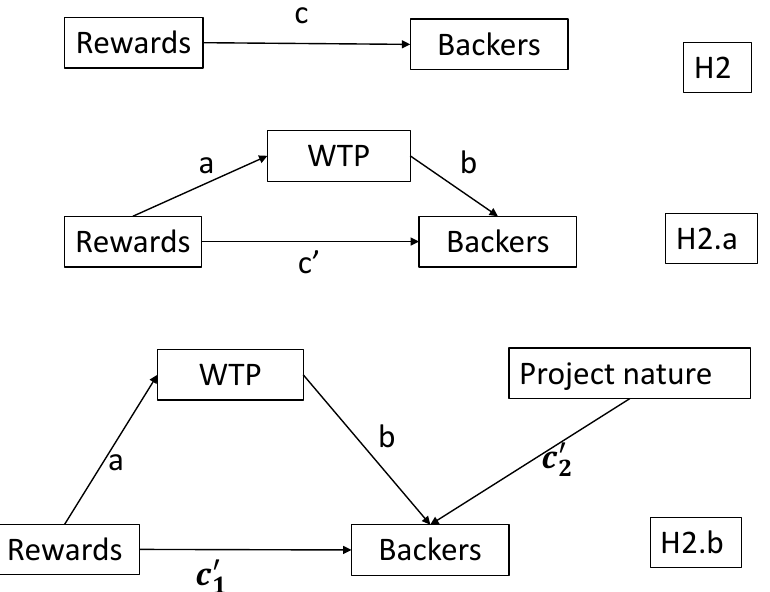
Figure 2. Basic, mediated and moderated mediation models of Rewards and WTP on Backers